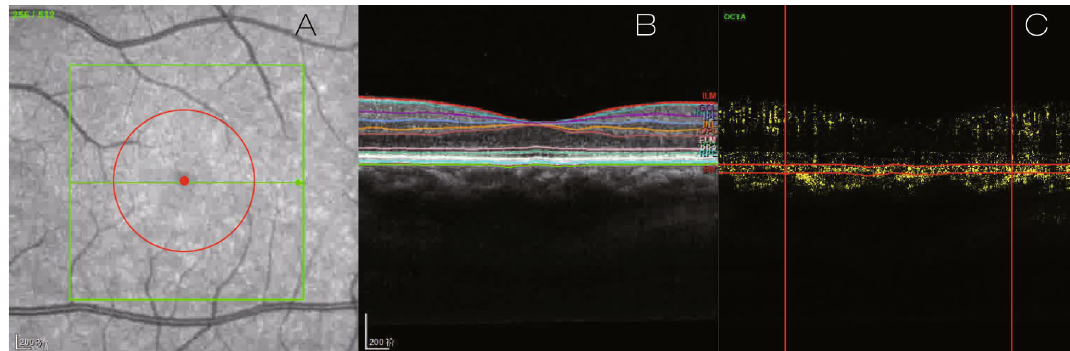
Figure 3. The 256th OCTA image. Yellow signals indicate blood flow signals. ( A ) En face image of structural OCT. Green rectangle is the scanned 3 × 3 mm 2 area. The red circle area indicates the 2000-μm-diameter macular area where we calculate CCBFSD. ( B ) OCT B-scan segmented image with yellow blood flow signal after manual adjustments. ( C ) OCTA B-scan image with yellow blood flow signal after self-written code process. The two horizontal red lines are inner and outer boundaries of choriocapillaris layer respectively. These two vertical red lines indicate the boundary of the 2000-μm-diameter macular area we calculated in the B scan OCTA image. The area enclosed by the above four lines is the area and blood flow signal we need to calculate in the 256th OCTA